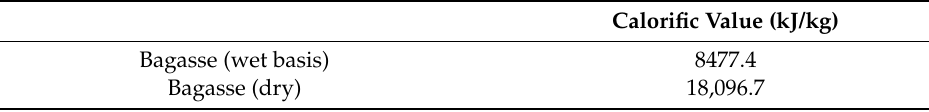
Table 1. Calorific value of sugarcane bagasse in